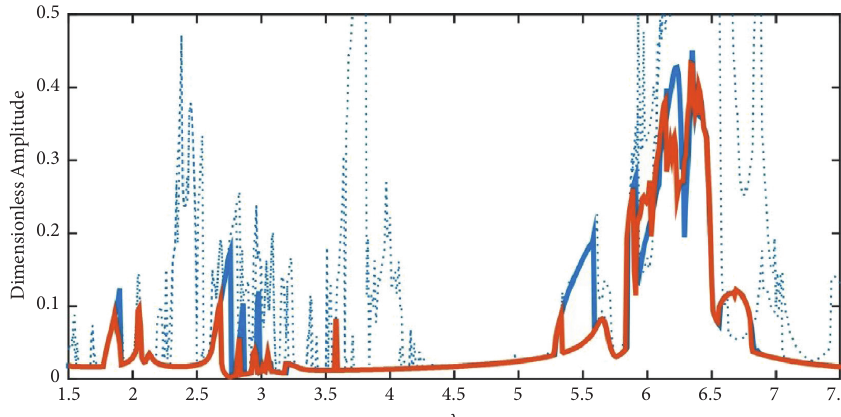
Figure 3: The amplitude-frequency curves and spectrum of responses of disc in horizontal direction when N curves, (b) spectrum at λ � 6 . 09, and (c) spectrum at λ � 6 . 38 (blue dot line means no SFD installed, solid line means the SFD is mounted, blue means run-up process, and brown means run-down